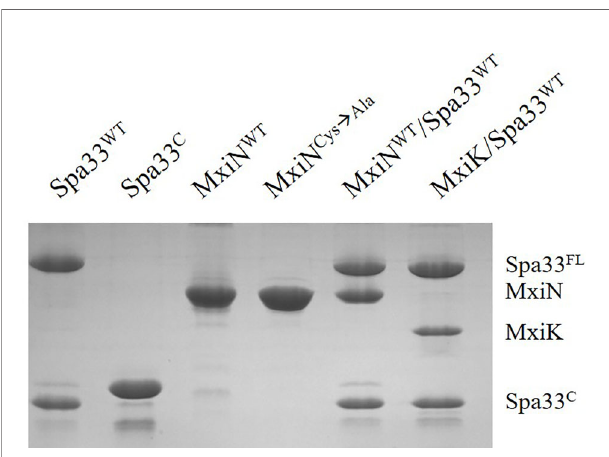
FIGURE 3 | SDS-PAGE analysis for all puri fi ed complexes containing Spa33. From the left, wild-type Spa33, Spa33 C , MxiN, a MxiN mutant with all Cys residues removed to allow future crystallography screens (fully active in vivo ), the MxiN-Spa33 complex formed in vitro and the MxiK-Spa33 complex puri fi ed after co-expression in E. coli. The Spa33 C (second lane) is slightly larger than the same component in the other lanes because it still possesses an N-terminal His 6 -tag. Recombinant Spa33 FL and MxiK alone are not soluble and could not be puri fi ed.